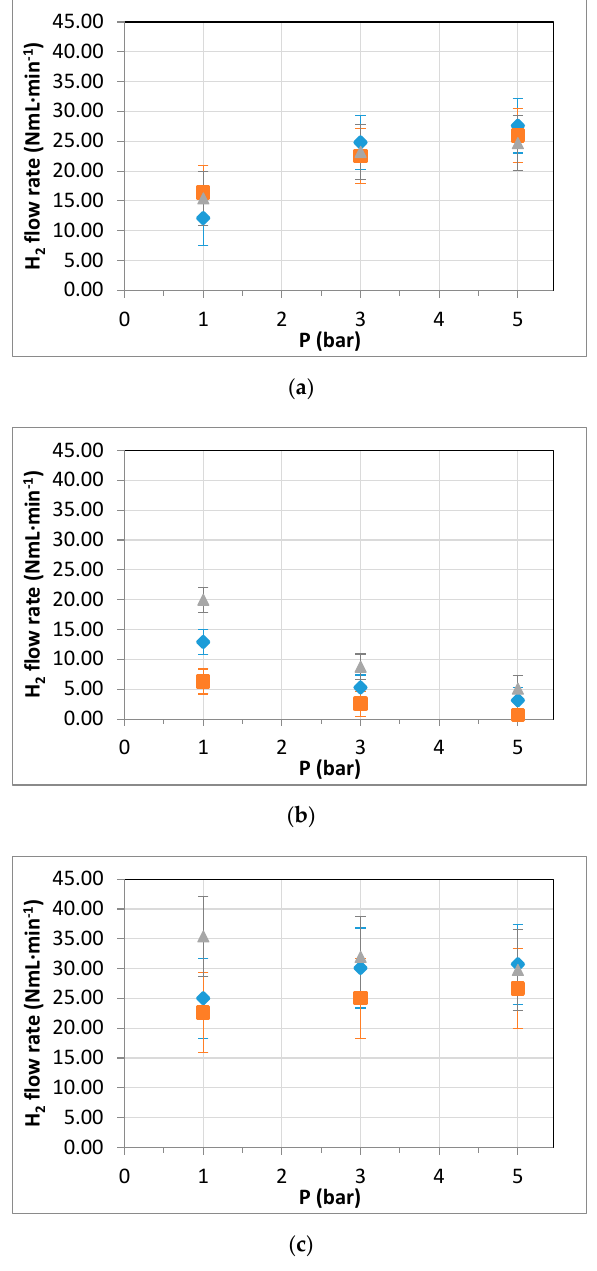
Figure 5. Effect of space velocity in OMW–EtOH co-reforming experiments (T = 450 °C, EtOH concentration 7.5% v / v , feed: variable): ( a ) permeate, ( b ) retentate, and ( c ) total produced hydrogen. Squares ( ): 10 g/h OMW–EtOH and 10 mL/min N 2 ; diamonds ( ): 15 g/h OMW–EtOH and 15 mL/min N 2 ; and triangles ( ): 20 g/h OMW–EtOH and 20 mL/min N 2 .